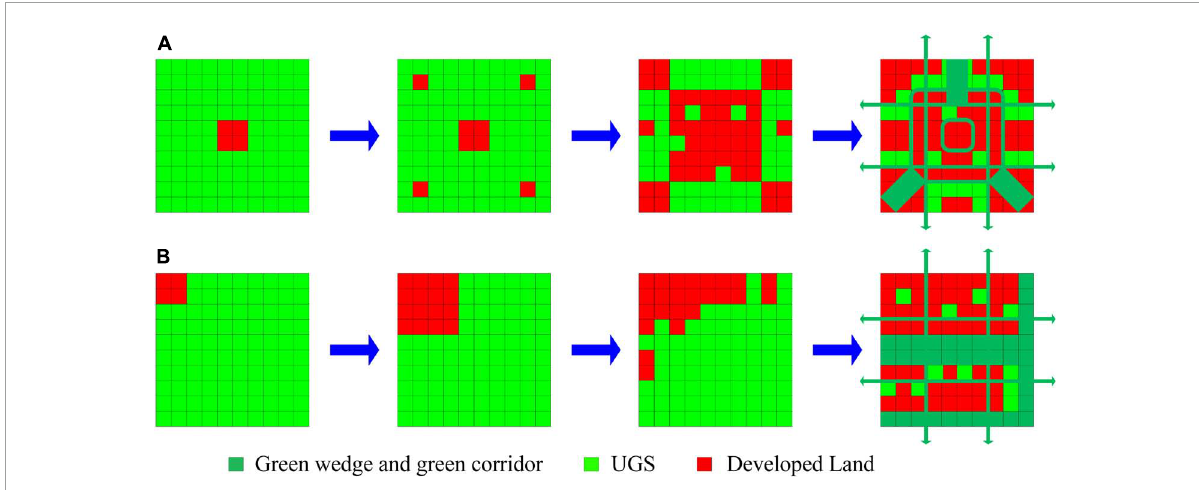
FIGURE11 Green space development process at old downtown (A) and new developing area